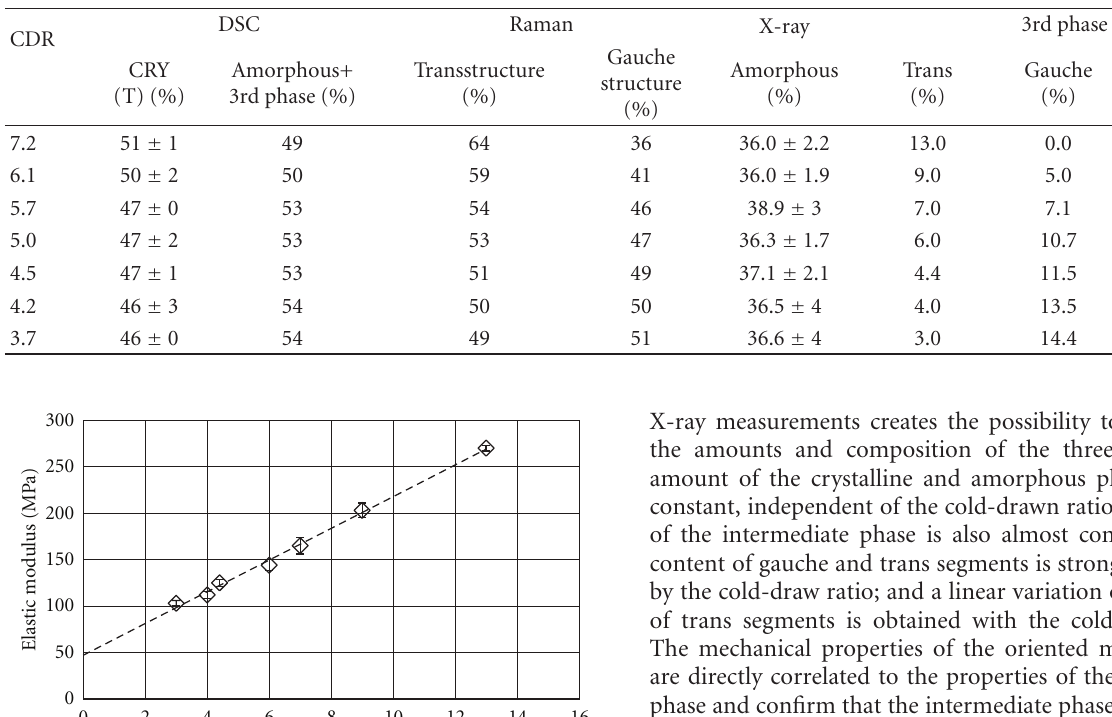
Table 3: Structure analysis of the three phases of the LLDPE monofilaments.